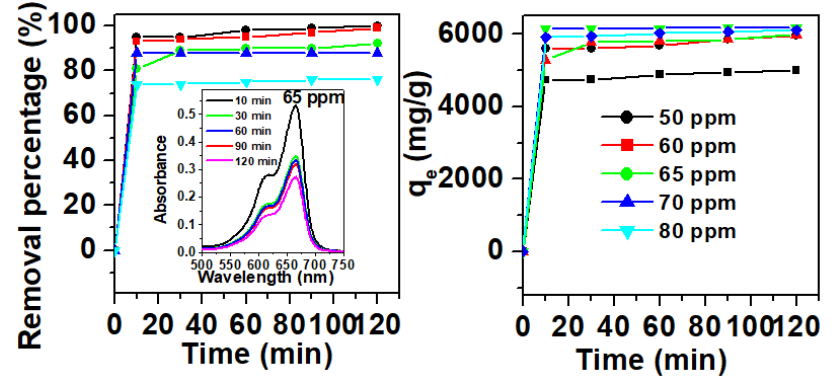
Figure 3. Removal efficiency of Fe 2 (MoO 4 ) 3 for methylene blue (MB) as a function of initial dye concentration and contact time (m adsorbent = 0.001 g, T = 20 °C). Inset: UV spectra of MB solutions (65 ppm) after contact with Fe 2 (MoO 4 ) 3 as a function of time.